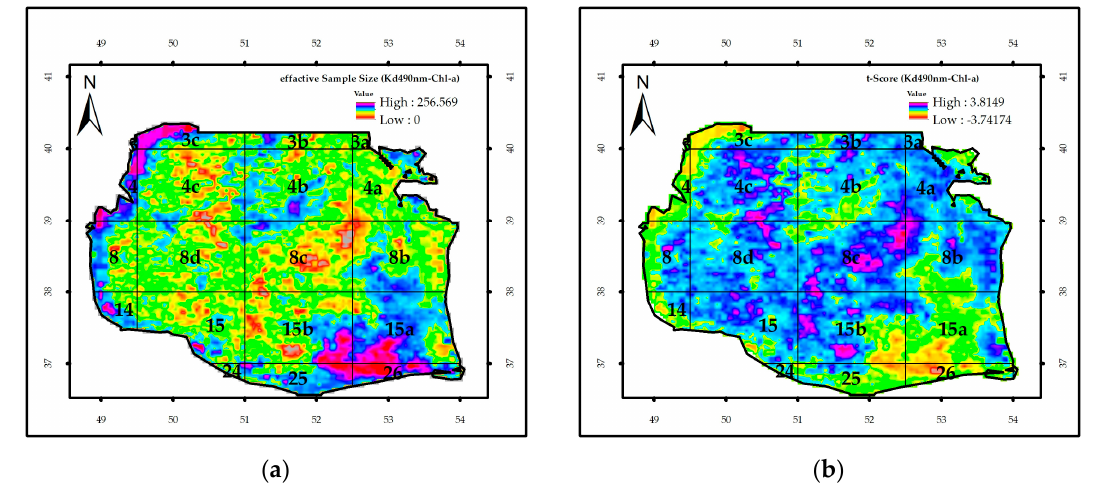
Figure 9. ( a ) The image of effective sample size (n e ), and ( b ) the value of t -test for the regression of Kd_490nm and Chl-a concentration in the SCS from 1998 to 2015.